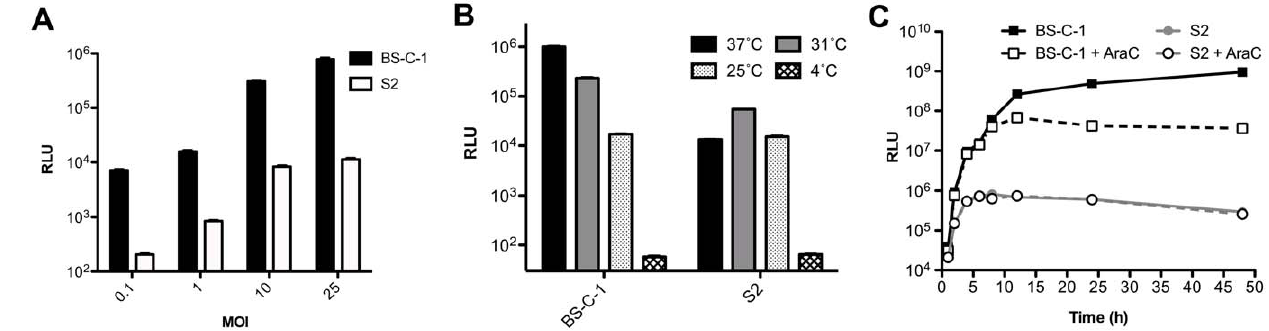
Figure 1. Entry of VACV in Drosophila S2 cells. A ) BS-C-1 and S2 cells were incubated with purified WRvFire virions at 4 u C at neutral pH for 1 h at the indicated MOI to allow attachment, washed, and then incubated for 1 h at 37 u C for BS-C-1 cells and 25 u C for S2 cells. Cells were lysed and Luc activity measured and plotted as relative light units (RLU). B ) Cells were infected as in panel A with a MOI of 2 PFU per cell and after virus attachment the plates were incubated at the indicated temperatures for 2 h and then assayed for Luc. C ) Cells were infected with an MOI of 1 PFU per cell as in panel A. After attachment, plates were incubated at 31 u C and Luc assays were made over a 48 h period. Note that the solid and dashed lines representing Luc activity from S2 cells in the presence and absence of AraC are practically superimposed. Standard error bars were plotted in all three panels but are too close to discern in some places.